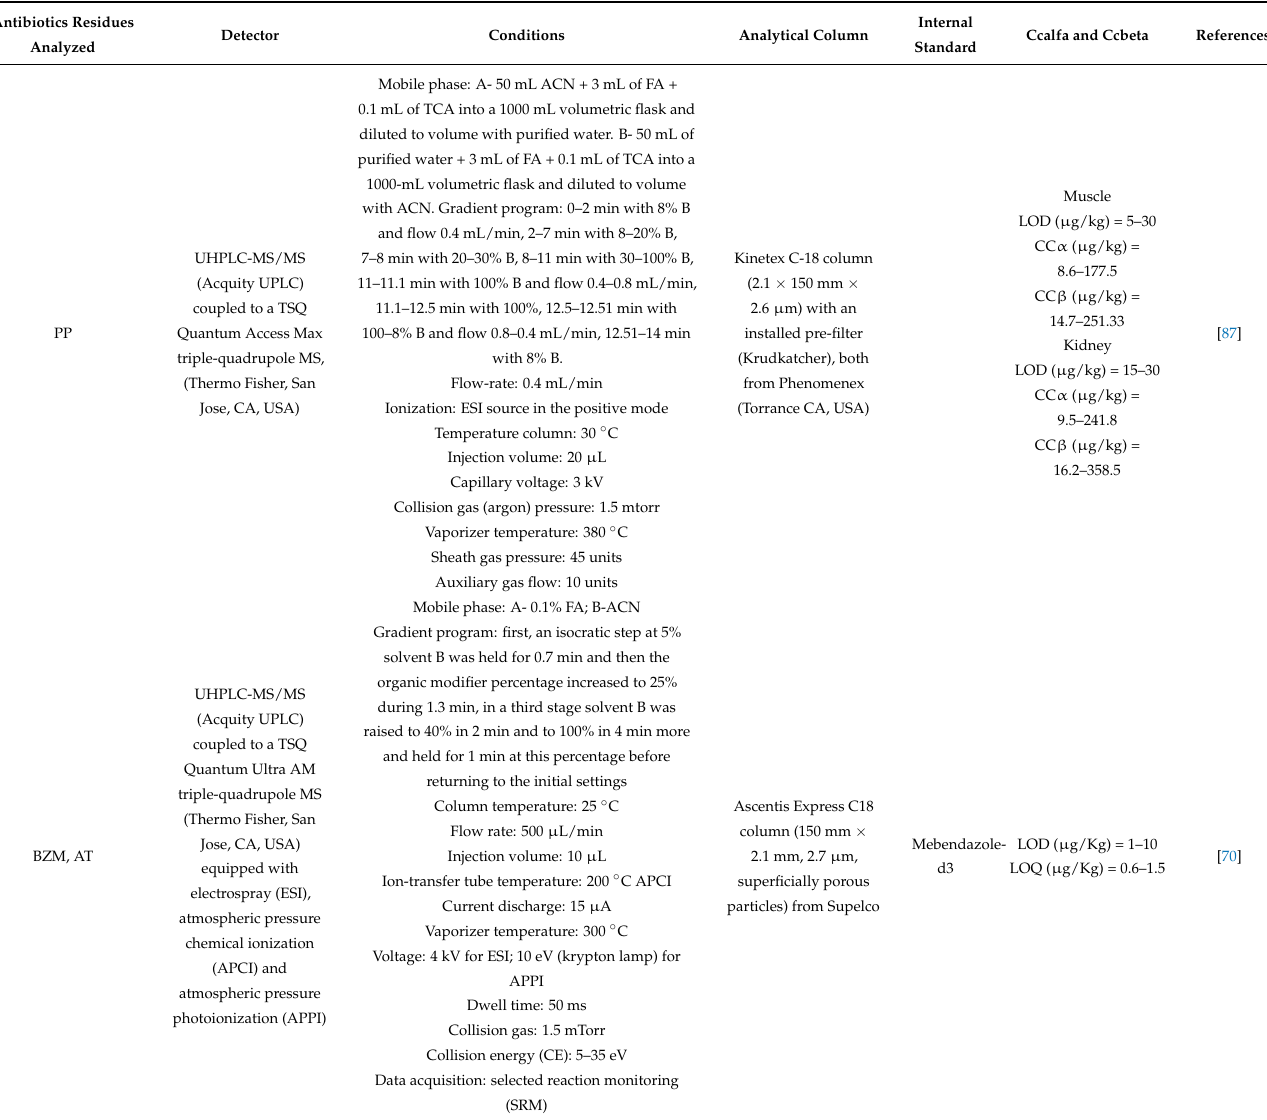
Table 4. Analytical methods for determination of antibiotic residues in foodstuffs. References are in chronological order for evaluation of the analytical